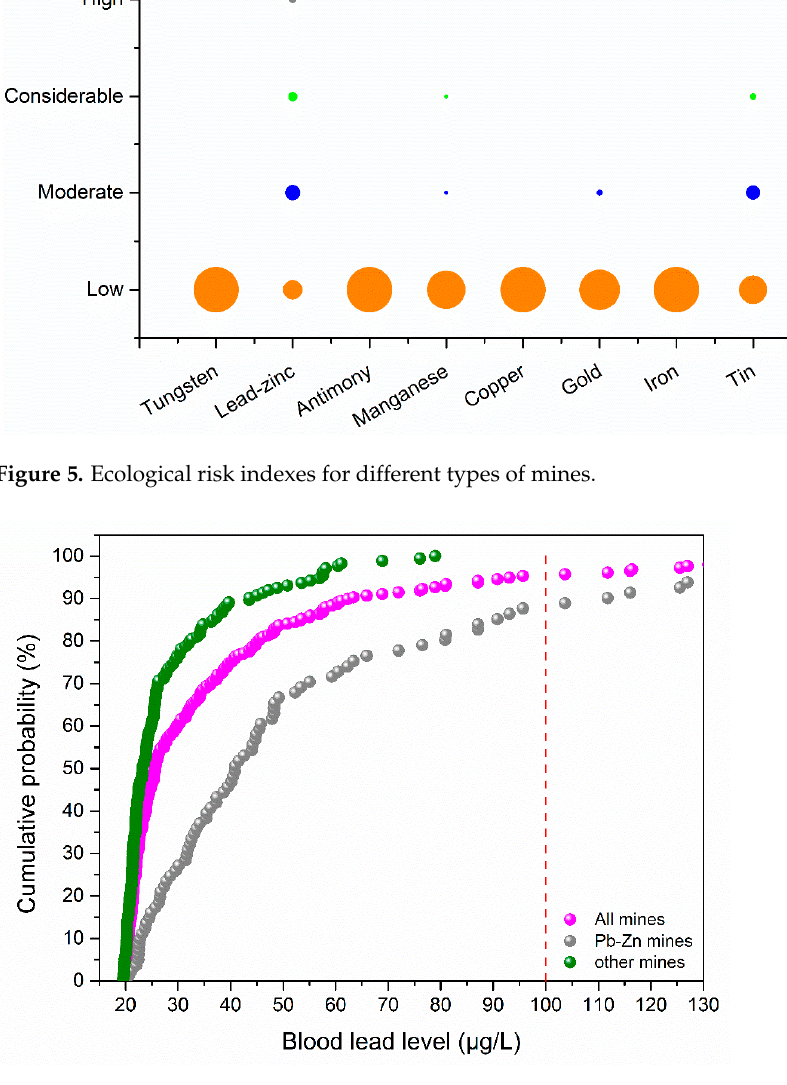
Figure 6. Cumulative probabilities of adult blood lead levels in mining areas.